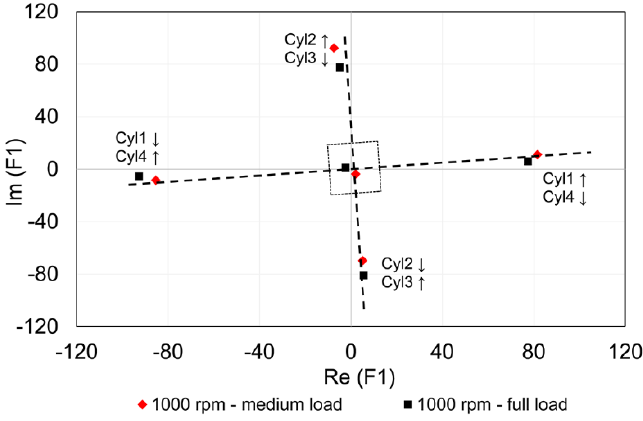
Figure 11. Representation in the complex plan of the F1 order at 1000 rpm and two loads in case of homogeneous injection and by varying the injected fuel in each cylinder of ± 5 mm 3 /cycle.